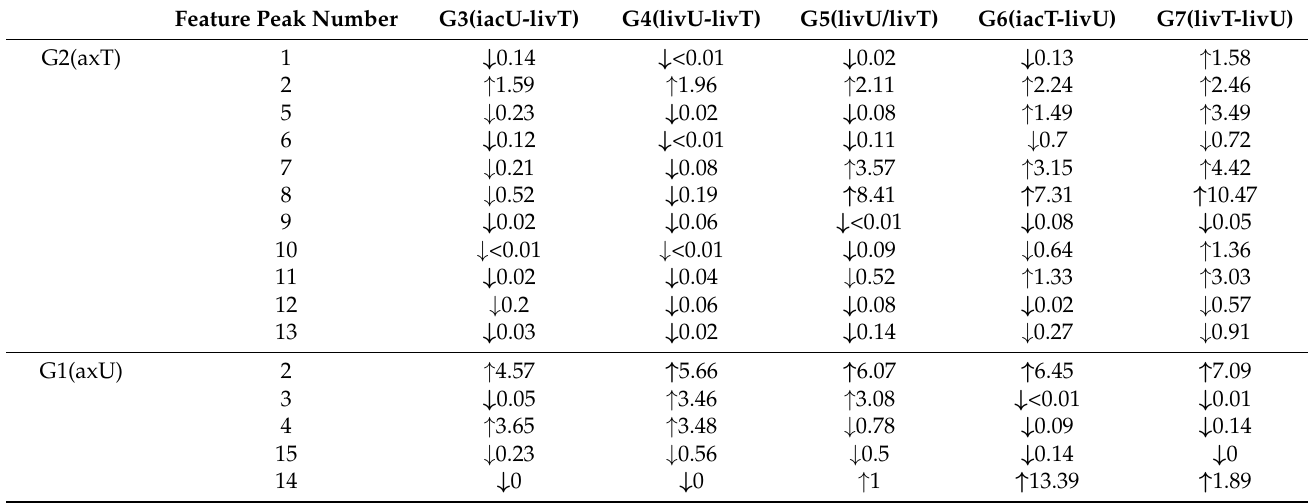
Figure 4. The HPLC traces of the culture extracts detected under the UV wavelength of 280 nm and the UV spectra for the featured peaks. The samples include axU (G1), axT (G2), iacU-livT (G3), livU-livT (G4), livU/livT (G5), iacT-livU (G6), and livT-livU (G7). The numbers marked on the peaks or in the UV spectra are numbers for the peaks with remarkable yield changes detected by mass spectrometry and are consistent with the peak numbers in Table 2. Table 2. The changing folds for the yields of the differential